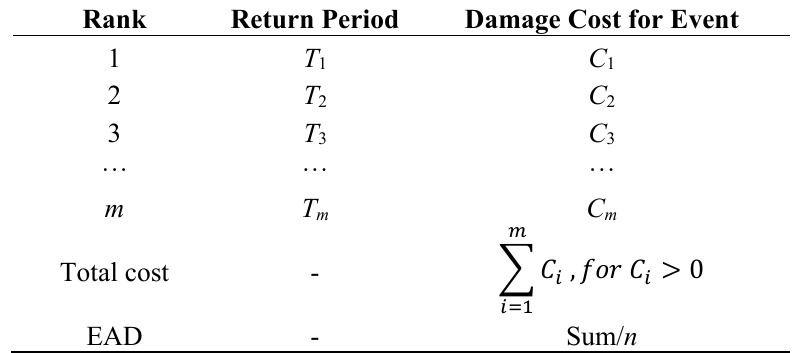
Table 2. Overview of calculation of expected annual damage (EAD) (using method (a)). Rank Return Period Damage Cost for Event 1 T